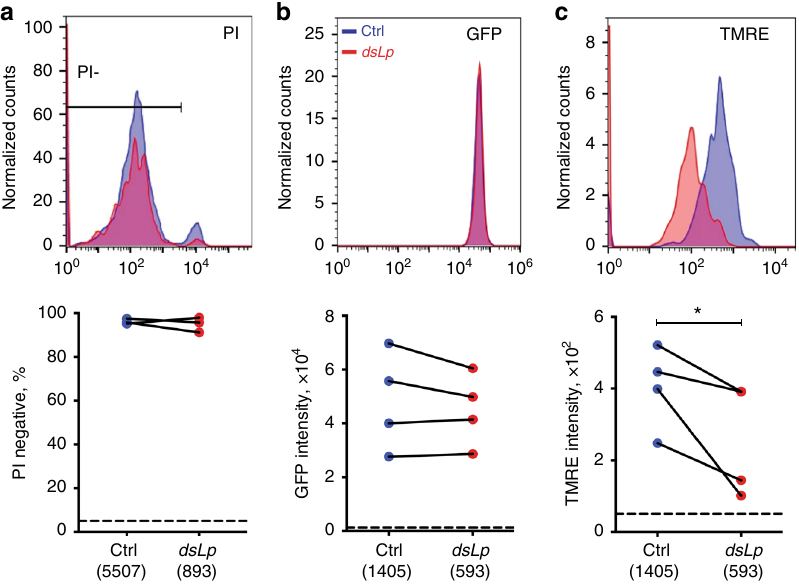
Fig. 4 Mosquito lipids regulate sporozoite metabolic activity. a Imaging fl ow cytometry of propidium iodide (PI) staining of sporozoites. Fluorescence intensity histogram from one representative experiment (top panel). Proportion of live PI-negative sporozoites (bottom panel) for control (blue) and lipid- deprived (red) sporozoites are shown ( N = 3). The dotted line shows the mean proportion of PI-negative heat-killed sporozoites. The total number of sporozoites are shown in brackets (12 – 35 mosquitoes per condition per experiment). p = 0.317; paired one-sided t -test, paired values for different dsRNA treatment per experiment. Imaging fl ow cytometry of b GFP (viability) and c TMRE (mitochondrial membrane potential) fl uorescence of control (blue) and lipid-deprived sporozoites (red). Fluorescence intensity histograms (top panels) from one representative experiment. Dot plots (bottom panels) represent geometric MFI per experiment ( N = 4). The dashed lines show the mean MFI of heat-killed sporozoites ( b ) and of sporozoites treated with an uncoupling drug CCCP ( c ). The total numbers of sporozoites are shown in brackets (28 – 88 mosquitoes per condition per experiment). b p = 0.1561; c * p < 0.05; one- sided paired t -test, paired values for different dsRNA treatment per